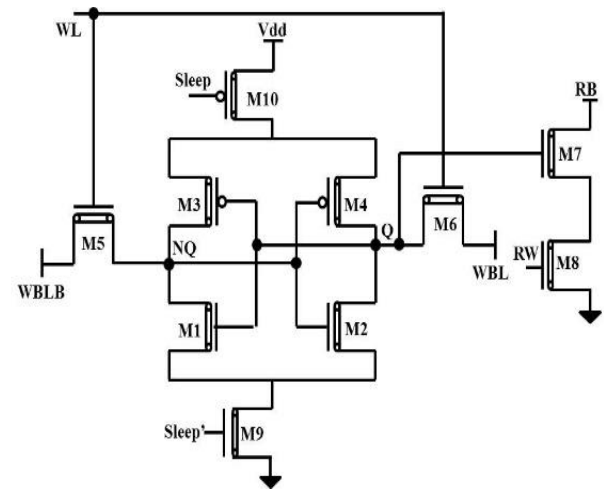
Figure 9. CNFET - Multi - Threshold 8T - SRAM cell.